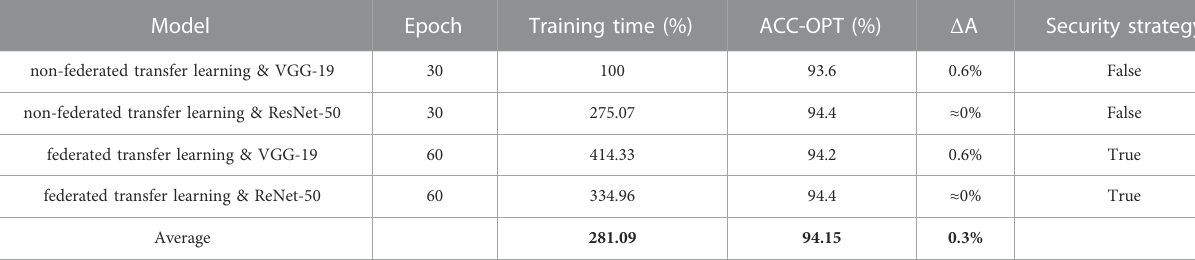
Bold values are highlighted for the average of the data in this column.